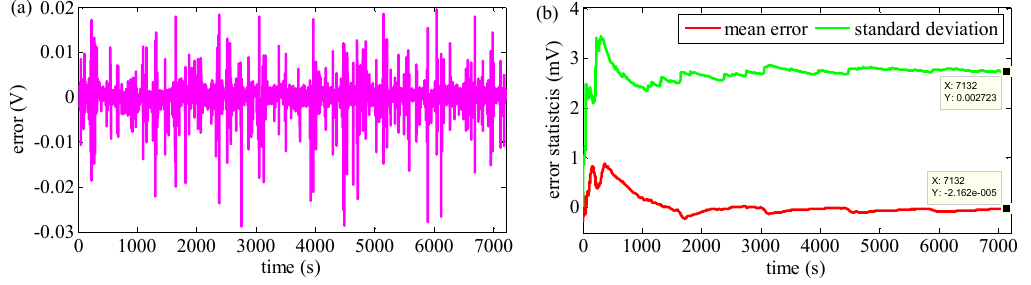
Figure 6. The comparison profiles of the terminal voltages: ( a ) The voltage error between the measured value and the online estimated value; ( b ) Error’s statistical